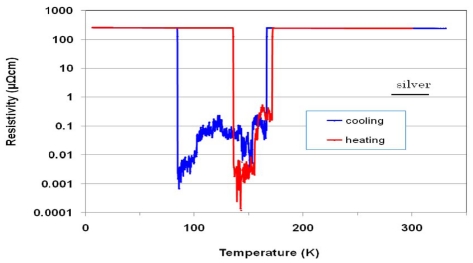
The temperature dependence of the resistivity of polished (Ni0.39Nb0.26Zr0.35)85H15 glassy alloy in cooling run (a) and heating run (b).